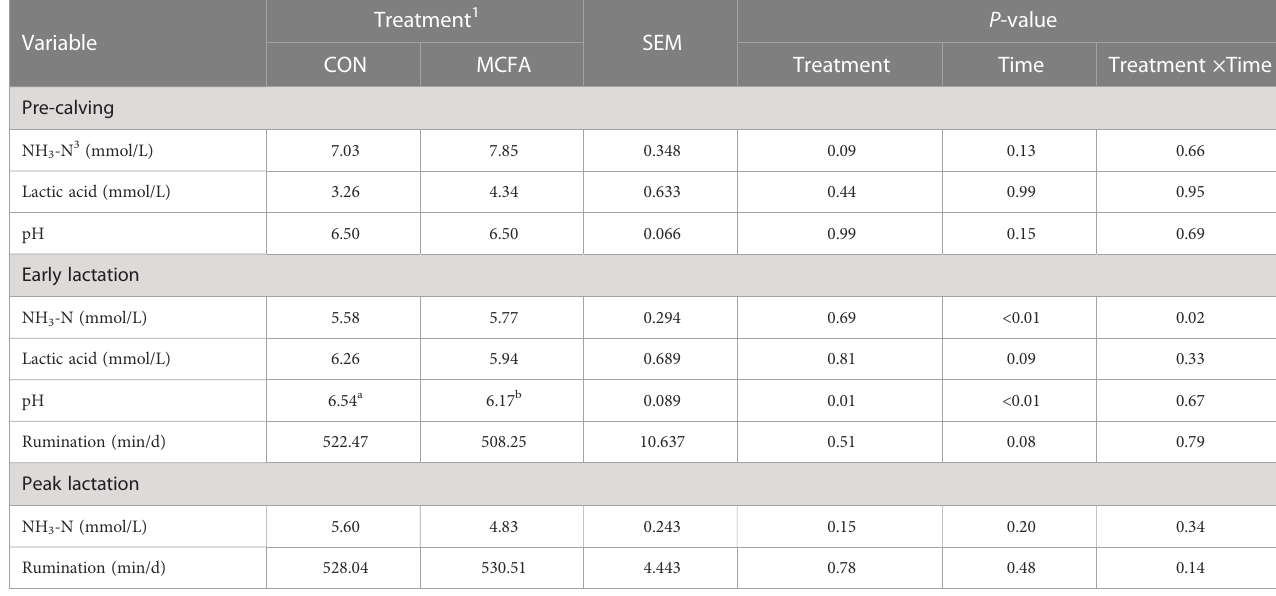
TABLE 10 Effects of feeding medium-chain fatty acid on rumen fermentation and ruminant behavior of pre-calving, early lactation, and peak lactation cows 2 .